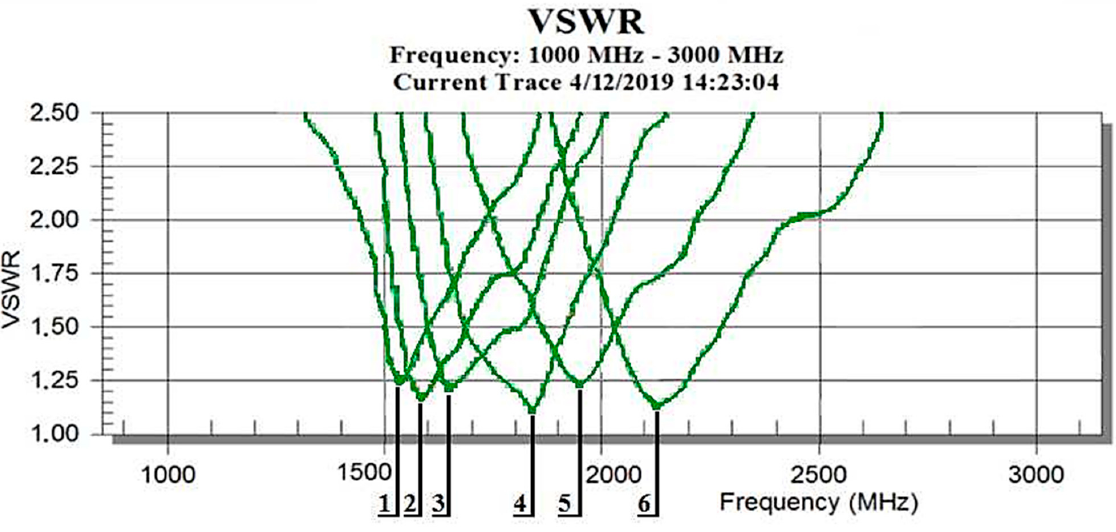
Figure 2. VSWR antenna recording for determining the value of the resonance frequency.